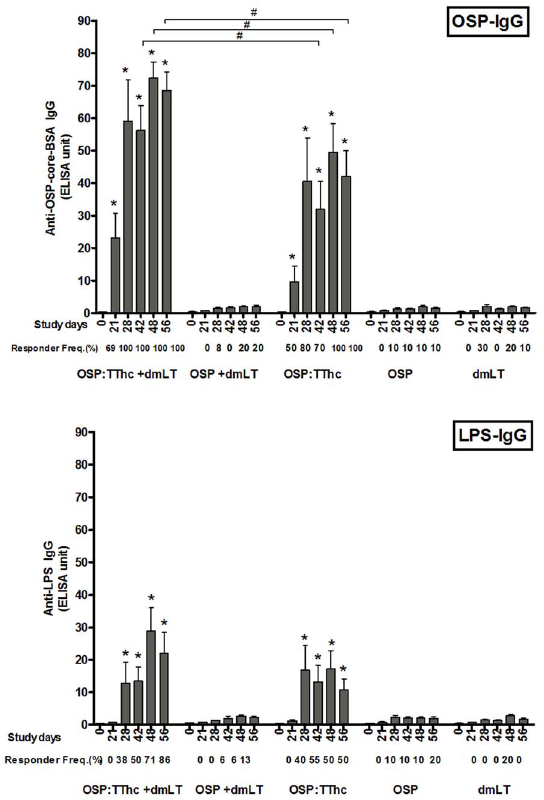
Figure 2. Serum anti-OSP-BSA and anti-LPS IgG antibody responses in mice intramuscularly immunized with OSP:TThc (with dmLT), OSP (with dmLT), OSP:TThc (no dmLT), OSP (no dmLT), or dmLT alone. Mean and standard error of the mean are reported for each group. An asterisk denotes a statistically significant difference ( P , 0.05) from baseline (day 0) titer. Responder frequencies are also listed. # , statistically significant difference among the compared cohorts ( P , 0.05).